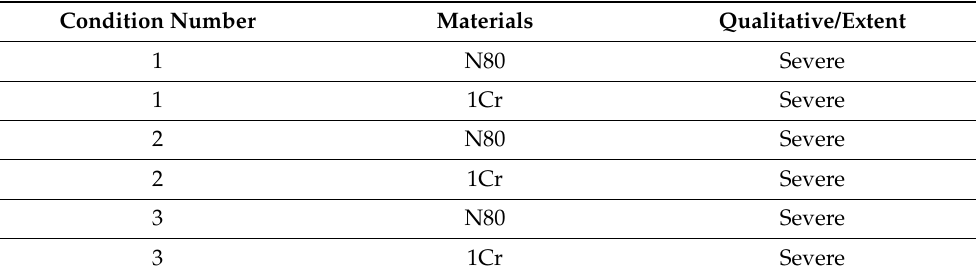
Table 4. General corrosion rate qualitative of N80 and 1Cr under three corrosion conditions.